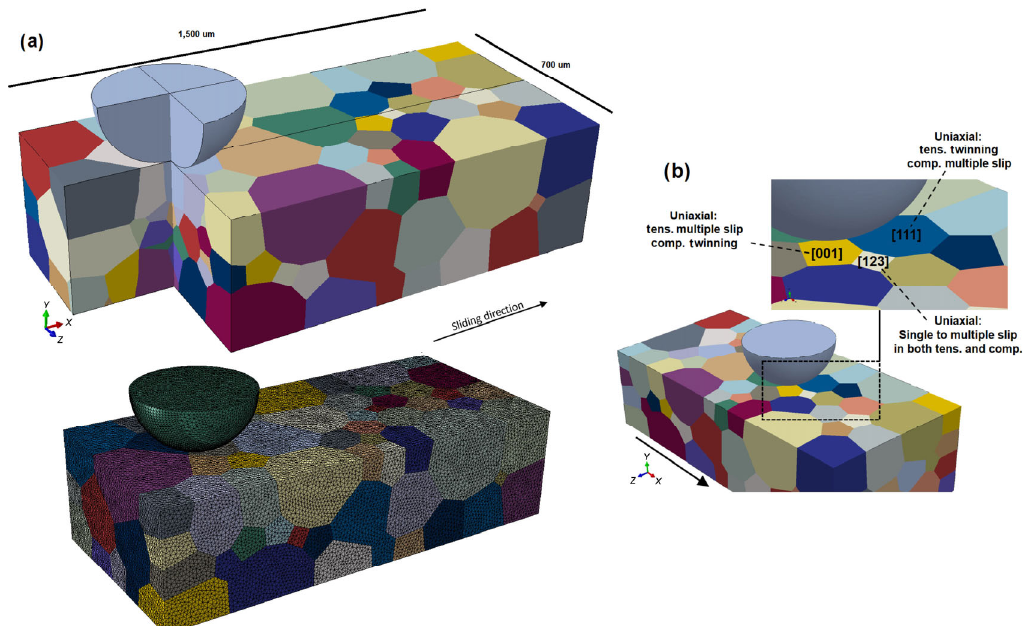
Fig. 1 (a) Sliding abrasive on a polycrystalline austenitic high manganese steel material (case I) and (b) specific single-crystal orientations selected into the scratch path (case